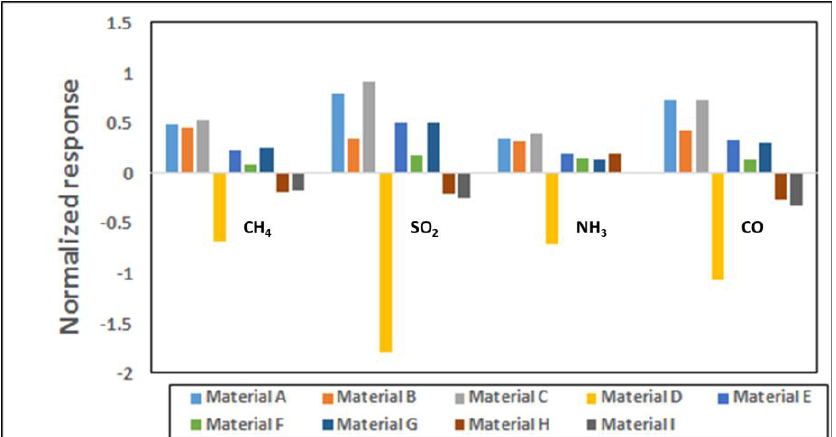
Figure 2. Normalized reponse in bar chart form for 25 ppm concentration of target gases CH 4 , SO 2 , NH 3 and CO. The error bars range from 1.5% to 6.0%. The nine materials are listed in Table S1.